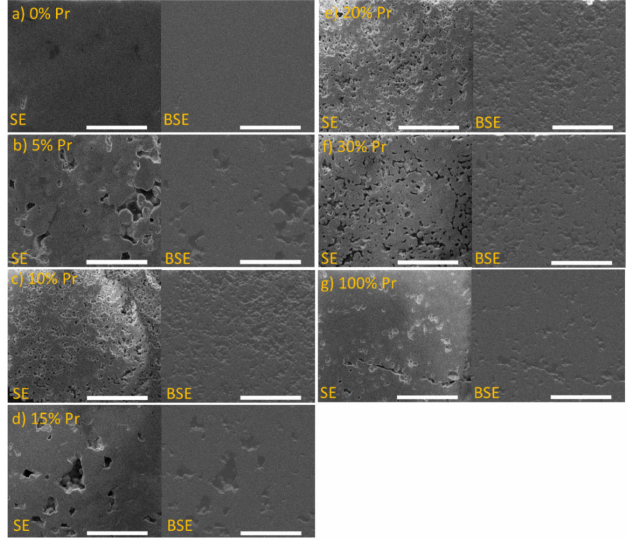
Figure 3. Scanning electron microscopy images of: ( a ) LaNbO 4+ δ ; ( b ) La 0.95 Pr 0.05 NbO 4+ δ ; ( c ) La 0.9 Pr 0.1 NbO 4+ δ ; ( d ) La 0.85 Pr 0.15 NbO 4+ δ ; ( e ) La 0.8 Pr 0.2 NbO 4+ δ ; ( f ) La 0.7 Pr 0.3 NbO 4+ δ ; ( g ) PrNbO 4+ δ